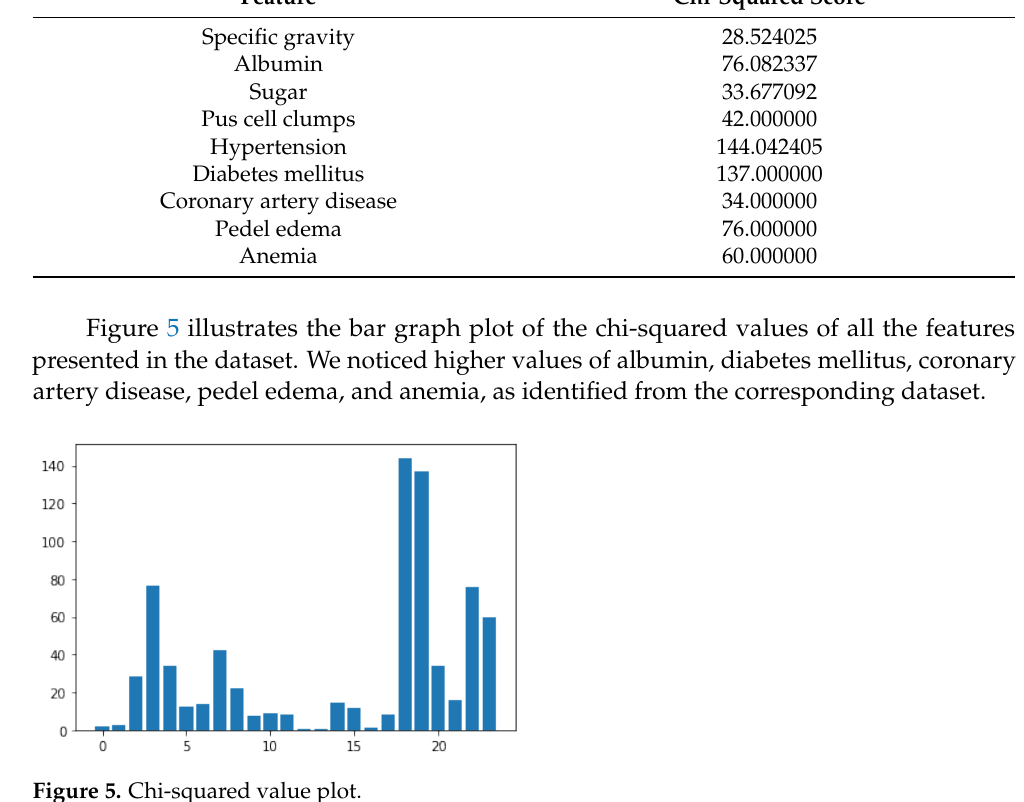
Figure 5. Chi-squared value